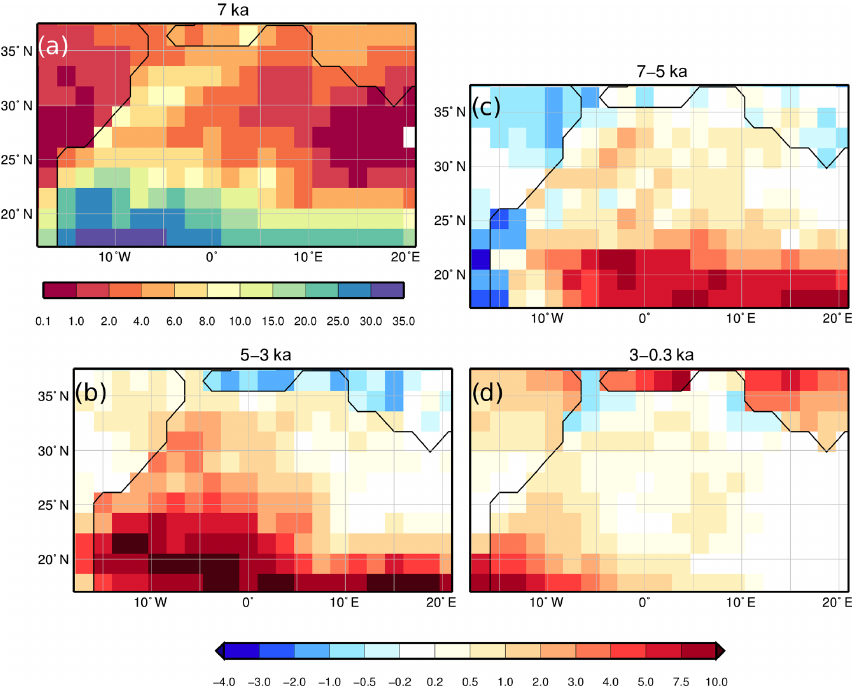
Figure 10. Number of rain events in September and October that exceed the 4mmd − 1 precipitation criteria for (a) the 7ka time slice, and for the differences in the number of rain events ( > 4mmd − 1 ) between time slices: (c) 7–5ka, (b) 5–3ka, and (d)